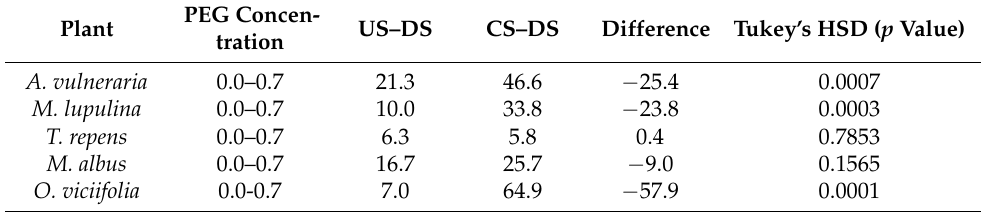
Table A3. Results of Tukey’s HSD test—DS, all plants.